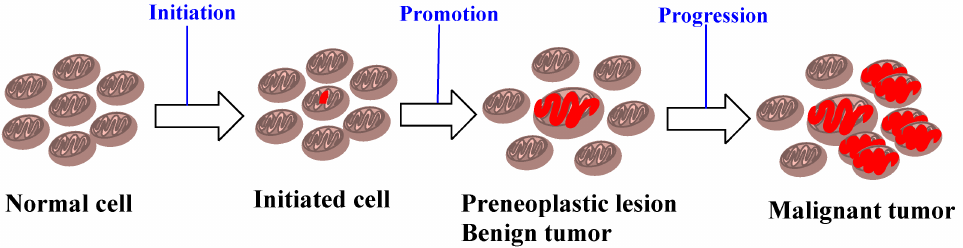
Figure 4. A brief depiction of initiation, promotion, and progression in the process of